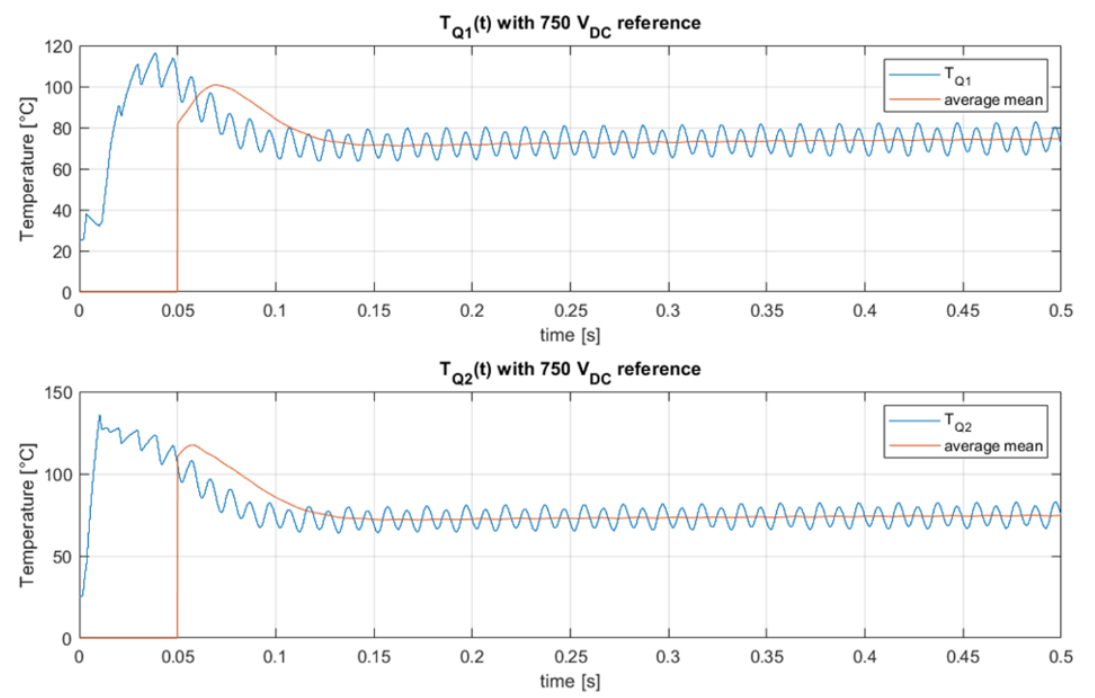
Figure 26. Thermal behavior of the GaN switching devices in the Totem Pole converter.